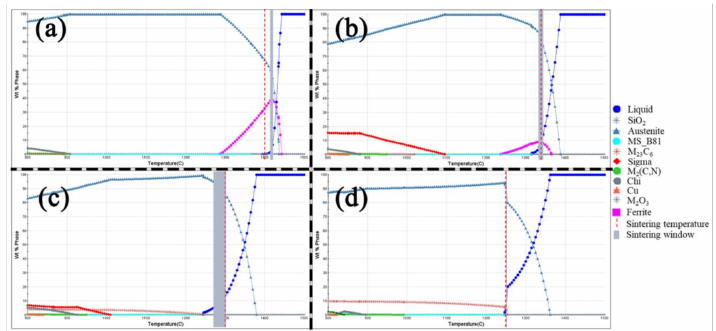
Figure 11. Temperature–phase composition curves of ( a ) 316 L stainless steel and austenitic stainless steels with ( b ) 0 ppm, ( c ) 2000 ppm, and ( d ) 5000 ppm